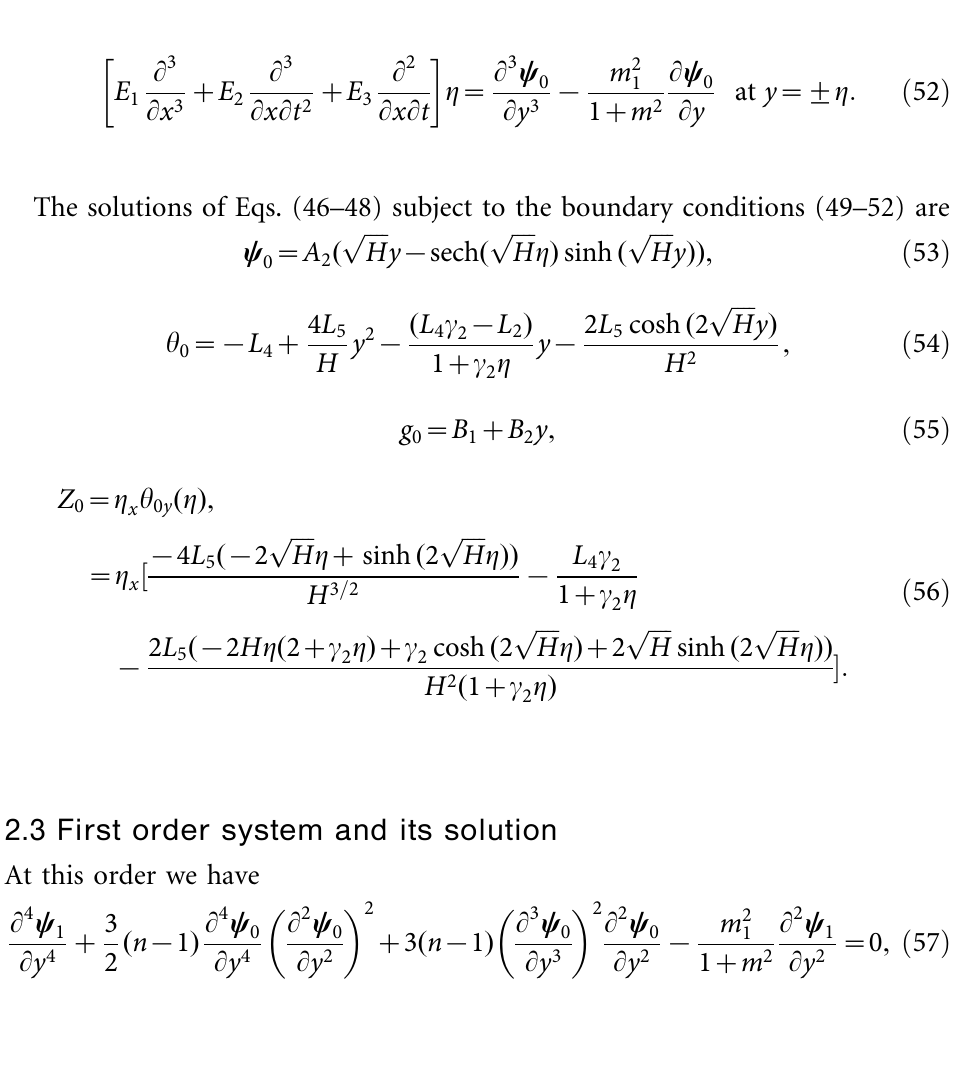
Figure 15. Plot of heat transfer coefficient Z for Weissenberg number We with E ~ 0 : 1 , t ~ 0 : 01 , ª 1 ~ 4 , ª 2 ~ 6 , E 1 ~ 0 : 4 , E 2 ~ 0 : 2 , E 3 ~ 0 : 3 , m 1 ~ 2 , n ~ 0 : 4 , Br ~ 1 and m ~ 0 : 04 :